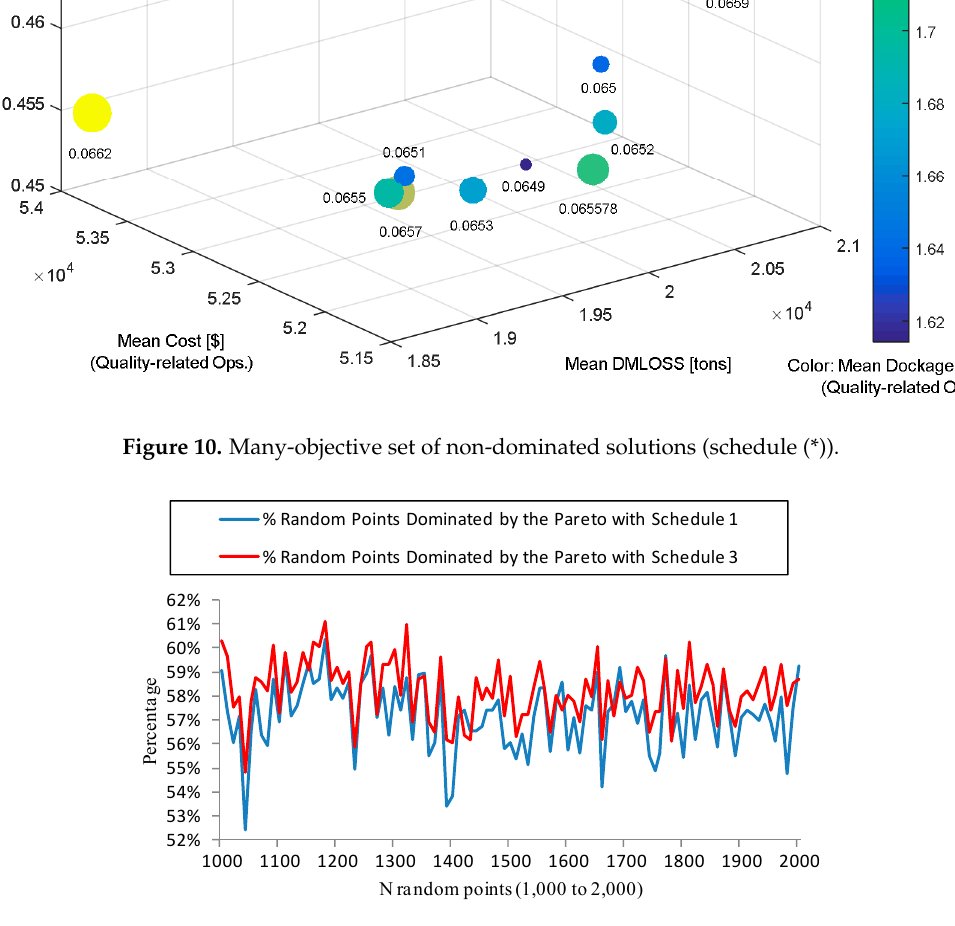
Figure 11. Hypervolume indicator approach (note: schedule 1 = schedule (*)).